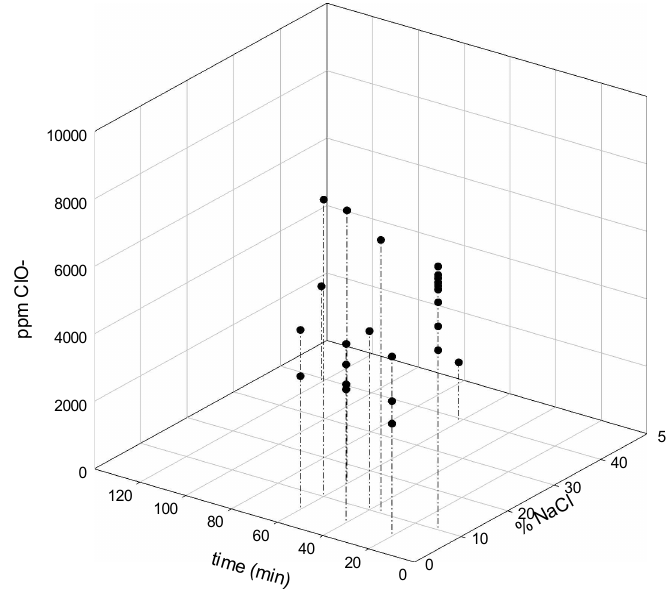
Figure 5. Hypochlorite production as a function of time and % NaCl in the initial screening.